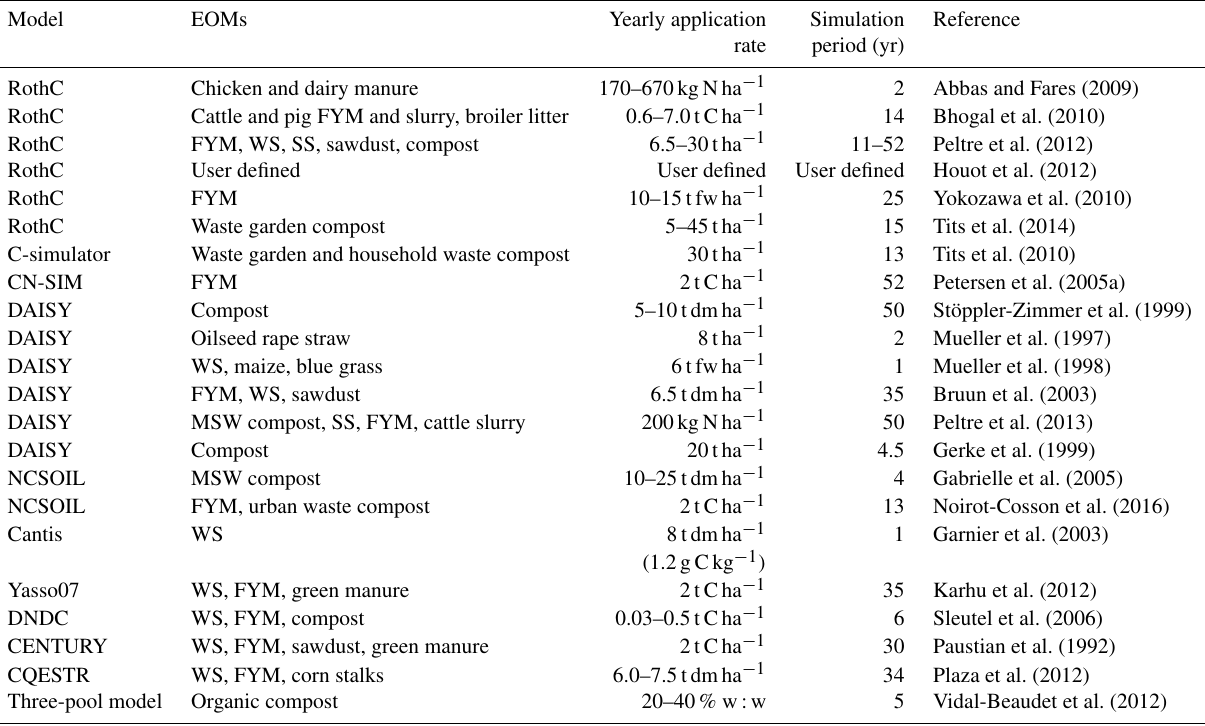
Table 1. Soil C models utilized for C simulation in amended soils.